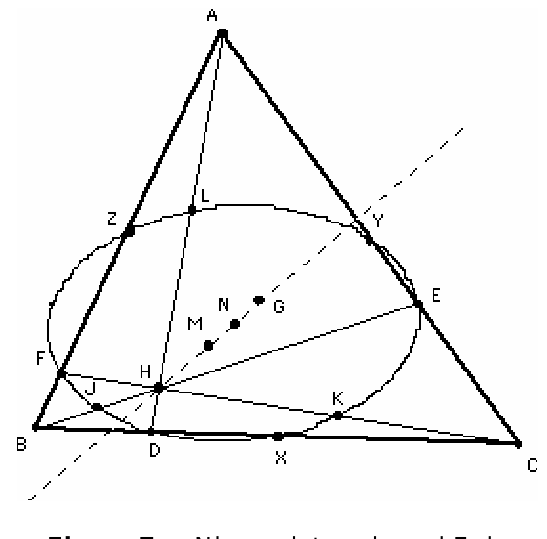
Figure 7. Nine-point conic and Euler line